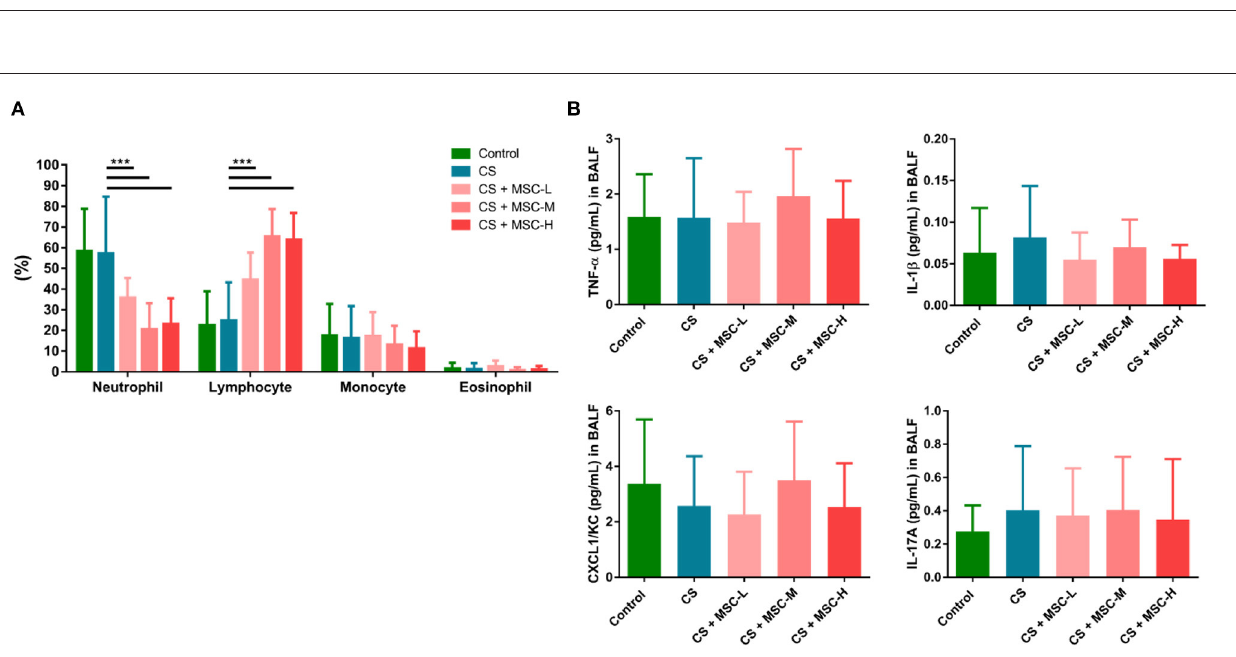
FIGURE 3 | (A) The human umbilical cord-derived mesenchymal stem cells (hUC-MSCs) reduced neutrophils and increased lymphocytes in bronchoalveolar lavage fluid (BALF) of mice. (B) Regulation of cytokine production (tumor necrosis factor (TNF)- α , interleukin (IL)-1 β , C-X-C motif chemokine ligand 1 (CXCL1)/keratinocyte chemoattractant (KC), and IL-17A) by hUC-MSCs in BALF. A significant decrease in neutrophils (%) was observed by hUC-MSC administration, whereas lymphocytes (%) increased after hUC-MSC administration. There was no significant difference in cytokine production in BALF after hUC-MSC administration. The results were determined by a one-way ANOVA with Tukey’s test. n = 8–10 per group. *** p < 0.001.